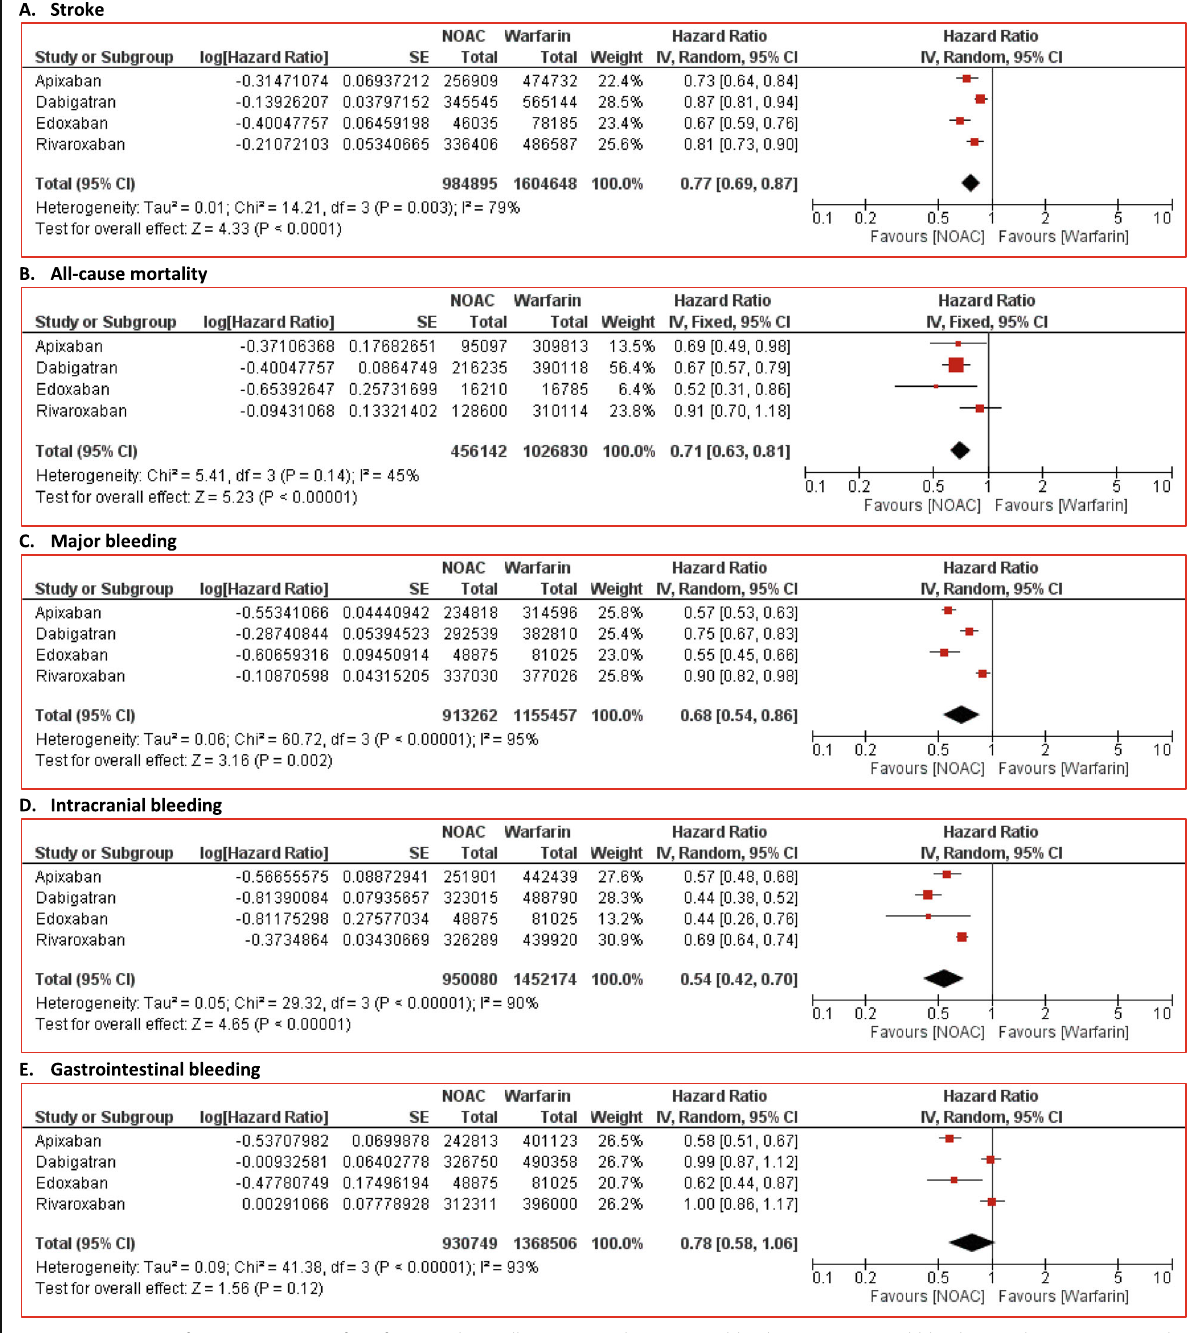
Fig. 2 Comparison of NOACs versus warfarin for A stroke, B all-cause mortality, C major bleeding, D intracranial bleeding, and E gastrointestinal bleeding. CI = confidence interval; NOACs = non-vitamin K antagonist oral